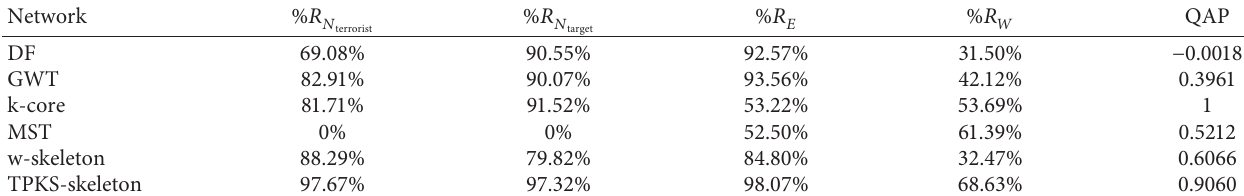
Table 5: The reduction in size and QAP correlation.